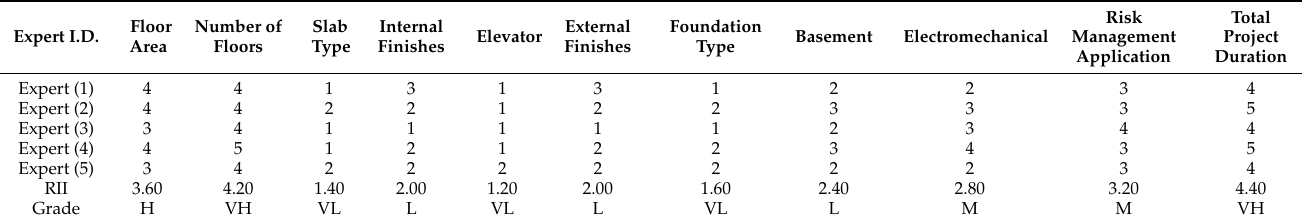
Table 4. The relative importance indices of critical